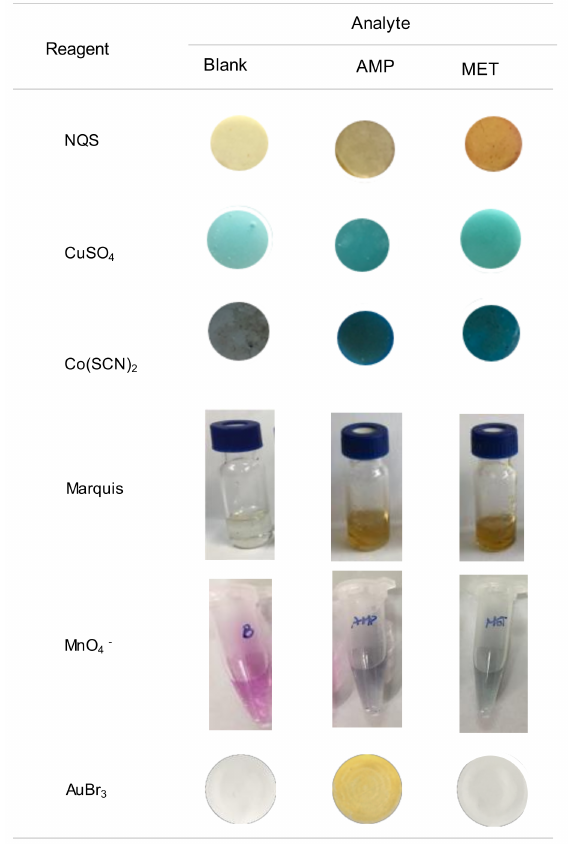
Figure 5. Images obtained for a blank and solutions of AMP and MET with different PDMS-sensors previously proposed for the analysis of drugs, and with the proposed